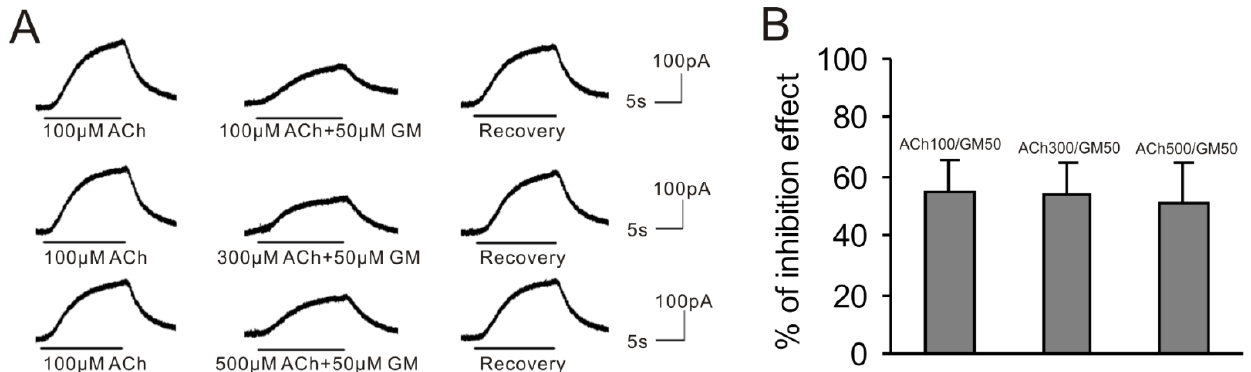
Figure 4. Increasing ACh concentration has little influence on GM inhibition effect. ( A ) The above currents were sequential current traces evoked by 100 µM ACh (ACh100) and different ACh concentrations (100, 300 and 500 µM) supplemented with 50 µM GM. The cell was clamped at −50 mV; ( B ) Bar histogram shows the percentage of the blocking effect of 50 μM GM supplemented with 100, 300 and 500 μM ACh on the current evoked by 100 μM ACh. Each point is the mean ± SD of 5